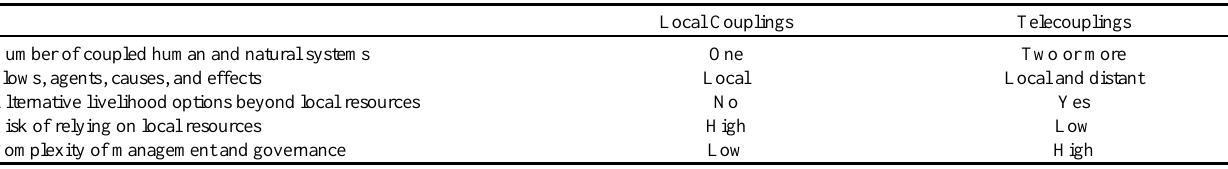
Table 4 . Differences between local couplings and